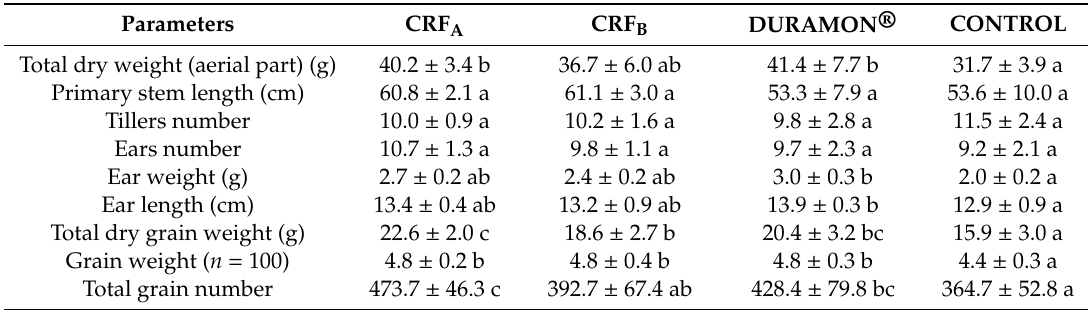
Table 3. Comparison of growth and grain yield parameters among the applied fertilizer treatments CRF A , CRF B , and DURAMON ® compared to the Control in Triticum aestivum . Values are means ± SD ( n = 10) at the end of the culture—138 days after plant emergence.